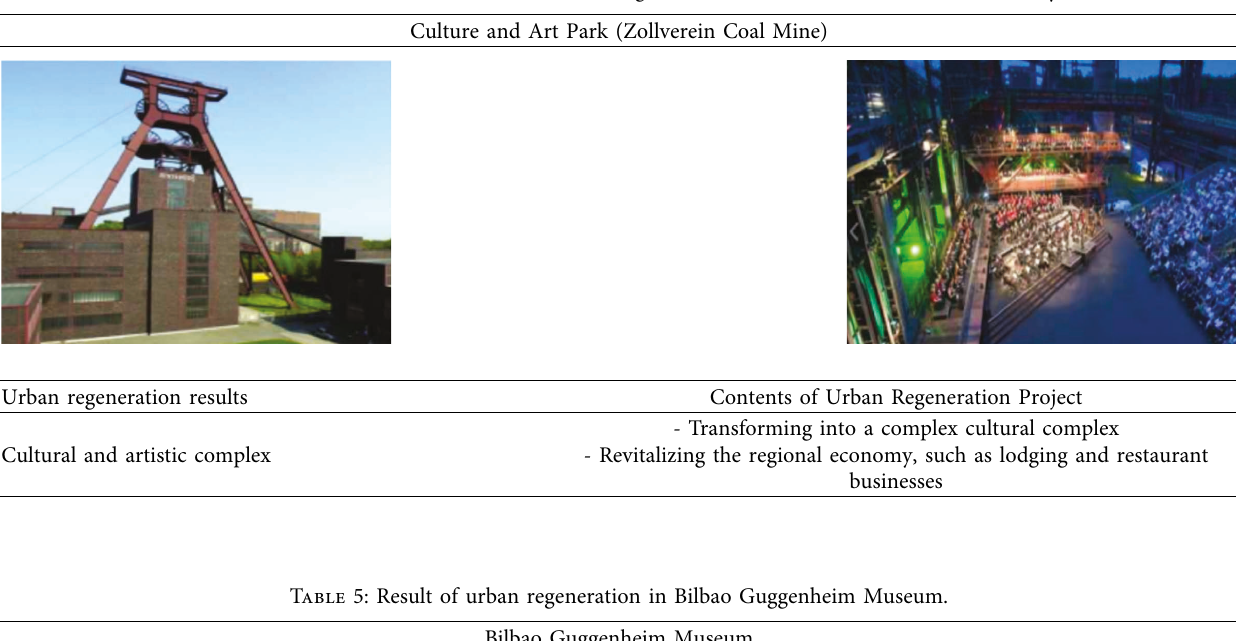
Table 4: Result of abandoned mine area urban regeneration in Zollverein Coal Mine,